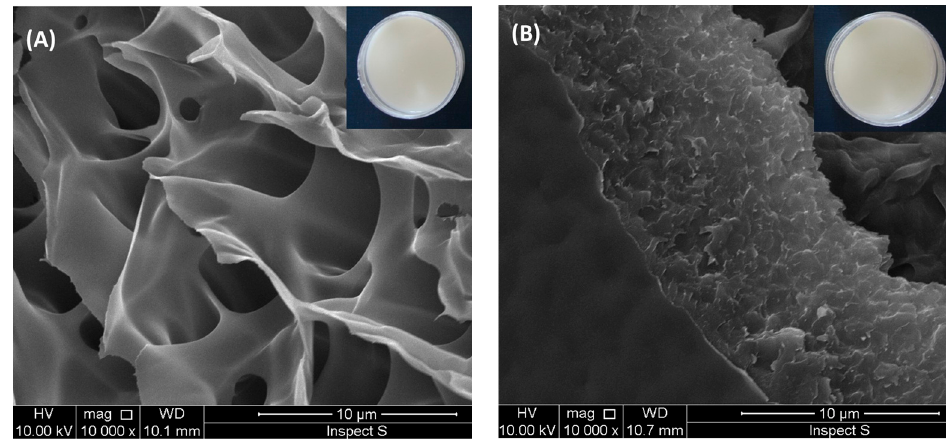
Figure 2. Scanning electron microscopy (SEM) images presenting cross-section microstructure of F1 ( A ) and F3 hydrogels ( B ) (original magnification 10,000×). Images of hydrogel F1 and F3 were shown insert.